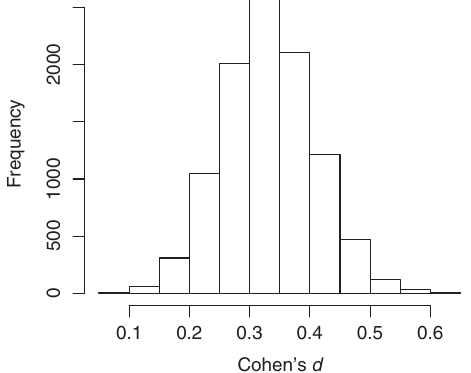
FIG. 4. The simulated sampling distribution of Cohen ’ s d for a test length of 10 items and class size of 80 (sample size ¼ 10 000 classes). The true value of Cohen ’ s d is 0.38.